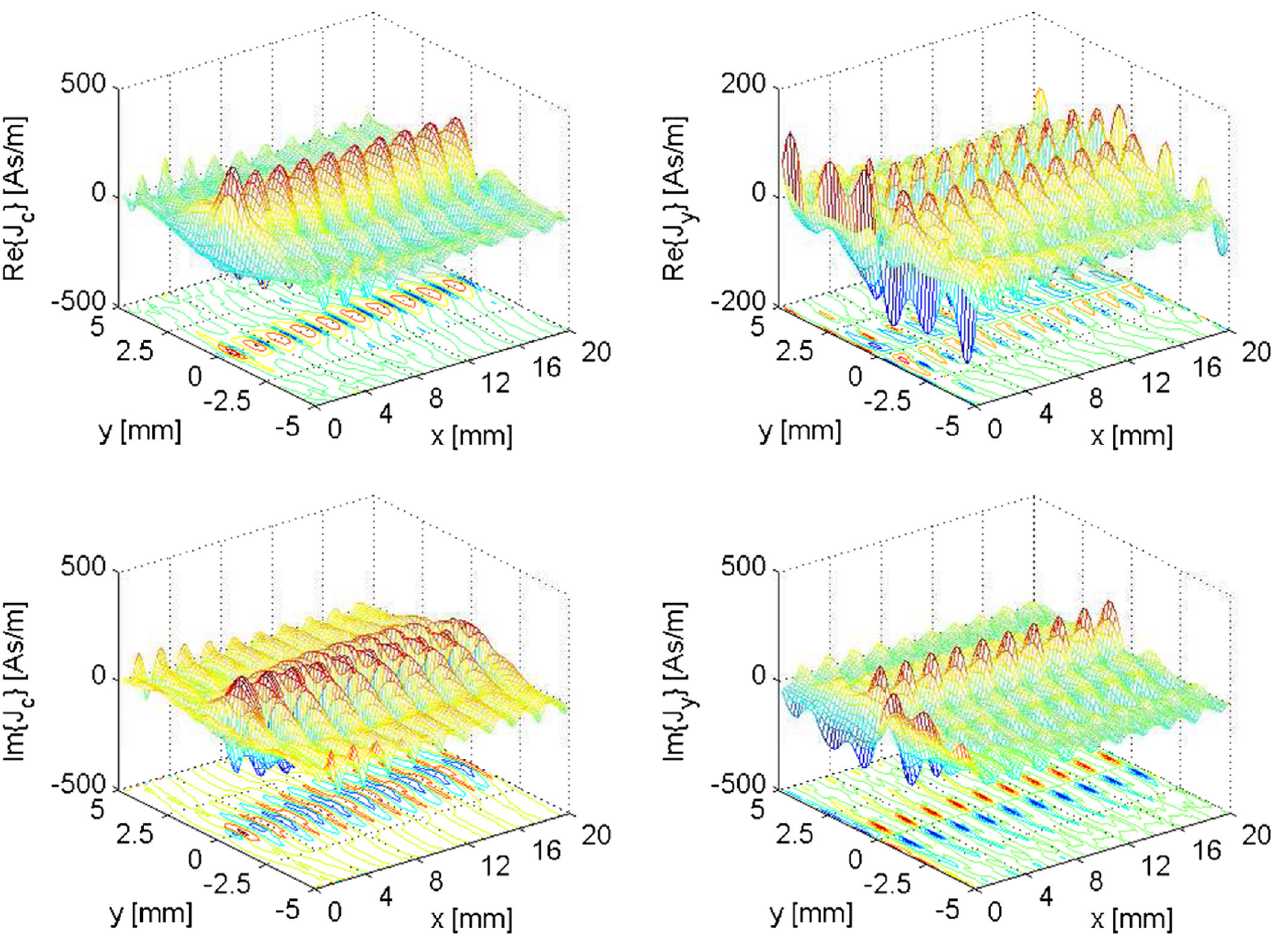
FIG. 3. (Color) Real and imaginary parts of the surface current components J frequency of 150